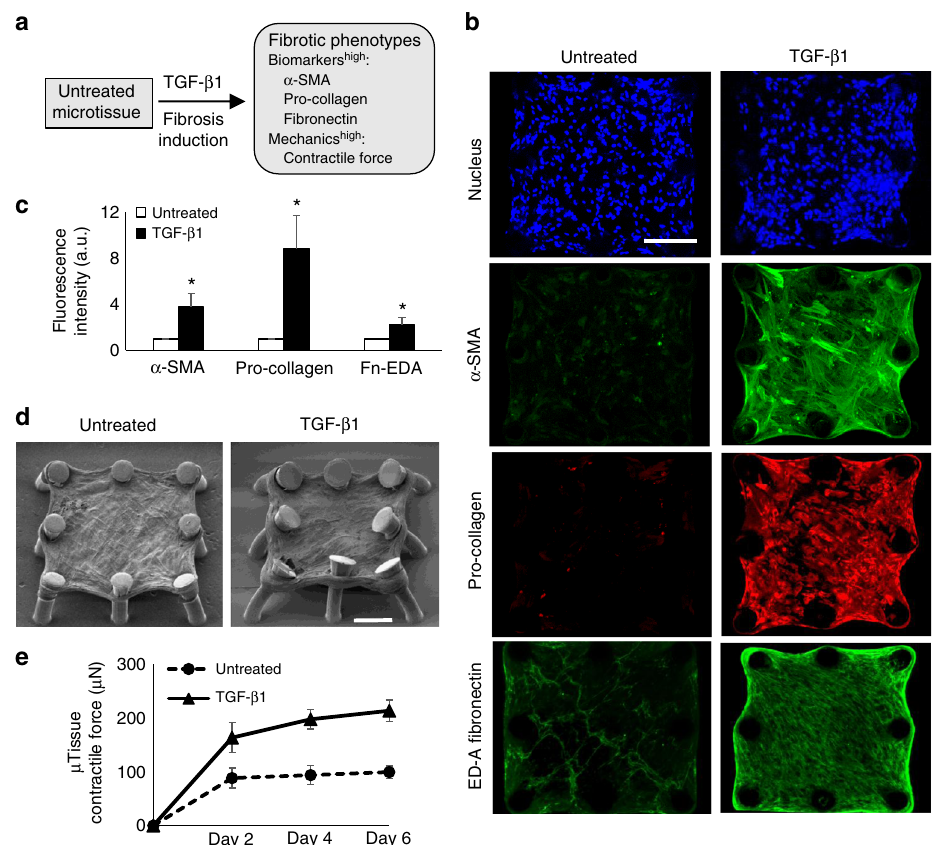
Fig. 2 Recapitulation of tissue fi brogenesis in lung microtissues. a Overview of the strategy for fi brosis induction and evaluation based on the measurements of biomarker expression and tissue contractile force. b Continuous TGF- β 1 treatment induced strong expressions of α -SMA stress fi bers, cytosolic pro-collagen, and EDA-Fibronectin (Fn) in lung fi broblast-populated microtissue, as illustrated by representative fl uorescent confocal images. c Fluorescence intensity levels of α -SMA, pro-collagen, and EDA-Fibronectin in TGF- β 1-treated and untreated microtissues. d SEM images of an untreated and a TGF- β 1-treated microtissue. Signi fi cant micropillar de fl ection caused by elevated tissue contraction can be seen in TGF- β 1-treated microtissue. e Time-lapsed microtissue contractile force measurement. Contractile force of TGF- β 1-treated samples nearly doubled that of untreated samples at every time point over a 6 day period. Data are reported as the mean ± SD. n ≥ 10; * P < 0.001 when compared to untreated condition by one-way ANOVA with Tukey test. Scale bar is 200 µ Recapitulation of tissue fi brogenesis in lung microtissues . Progression of fi brosis in lung interstitial tissue involves tissue stiffening and fi broblast activation into contractile myo fi broblasts, characterized by expression of smooth muscle actin ( α -SMA).